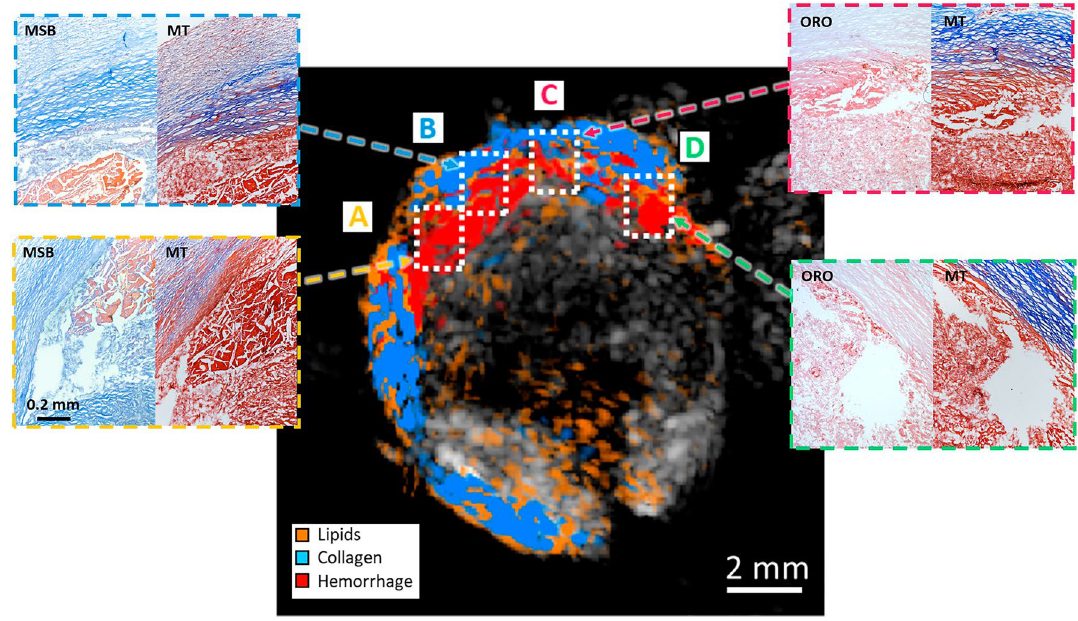
Figure 6. MSPAI unmixing of Intra-plaque hemorrhage sample sing selected wavelengths. White boxes in the proportions image indicate the location of the histology images. There is a good correlation between the collagen predictions with the MT staining. Hemorrhage (mainly methemoglobin) regions correlate with the fibrin regions (orange) in MSB for regions A and B, and with the empty areas in regions C and D, typically due to blood leaking out during sample